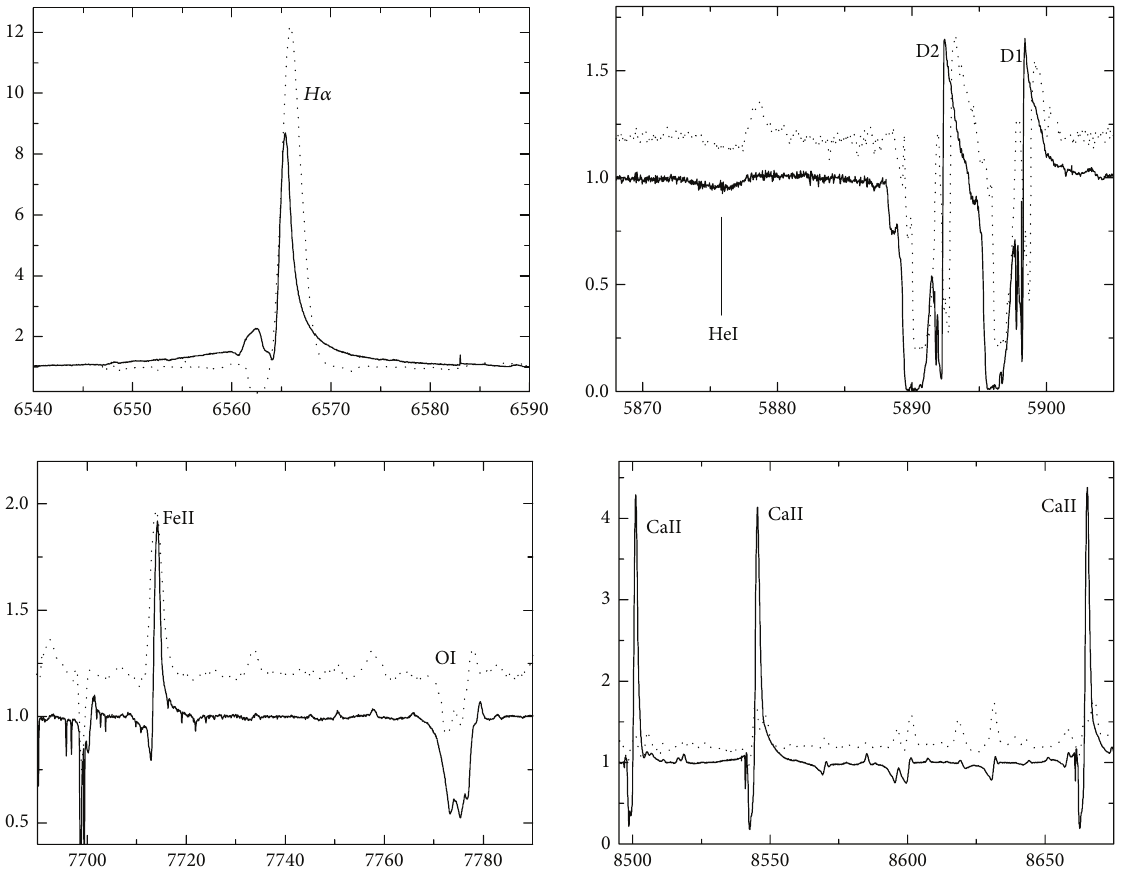
Figure 2: Spectra of MWC 930 obtained at the visual minimum dotted lines and maximum solid lines. The visual minimum spectra were obtained in October 2001 (upper panels) and July 2004 (lower panels). The visual maximum spectrum was obtained in June 2012 (all panels). The intensity is shown normalized to the underlying continuum, and the wavelengths are in Angstroms and